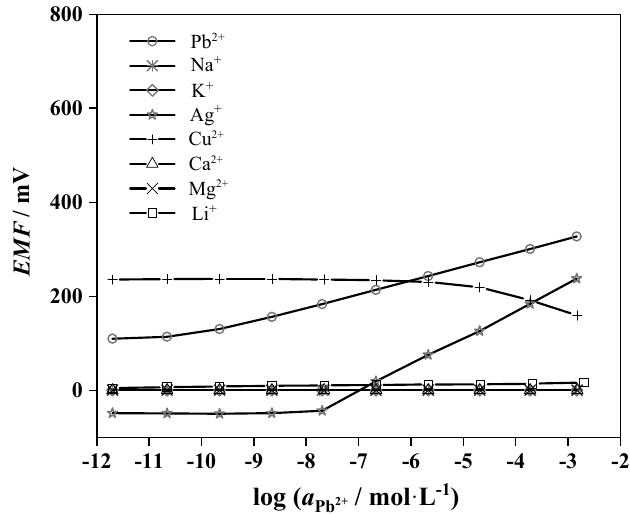
Figure 4. Dynamic potentiometric response of Au/MWCNTs/(MMA ‐ BA) ‐ Pb 2+ ‐ ISEs with increasing